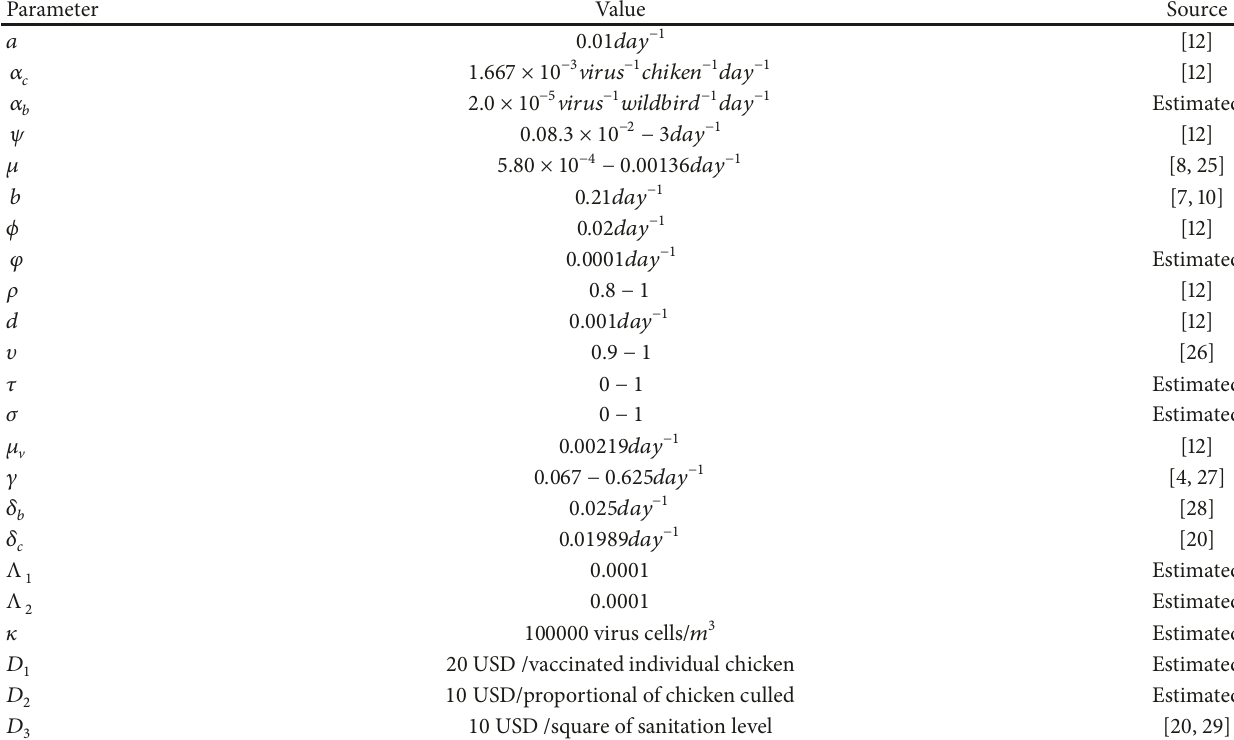
Table 1: The Parameter values used for running system